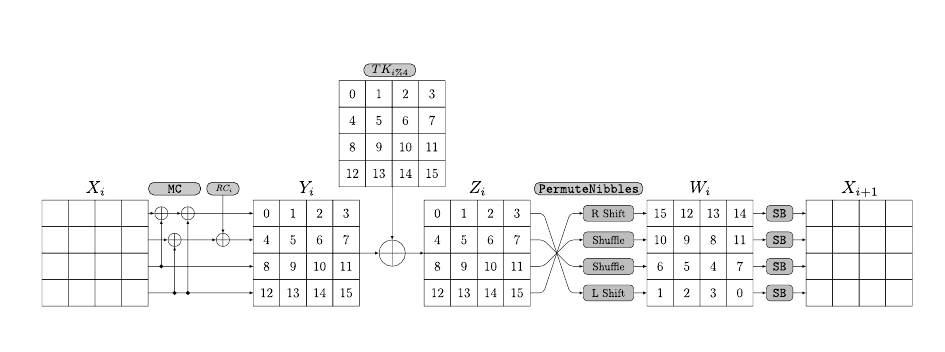
Figure 6: A round of